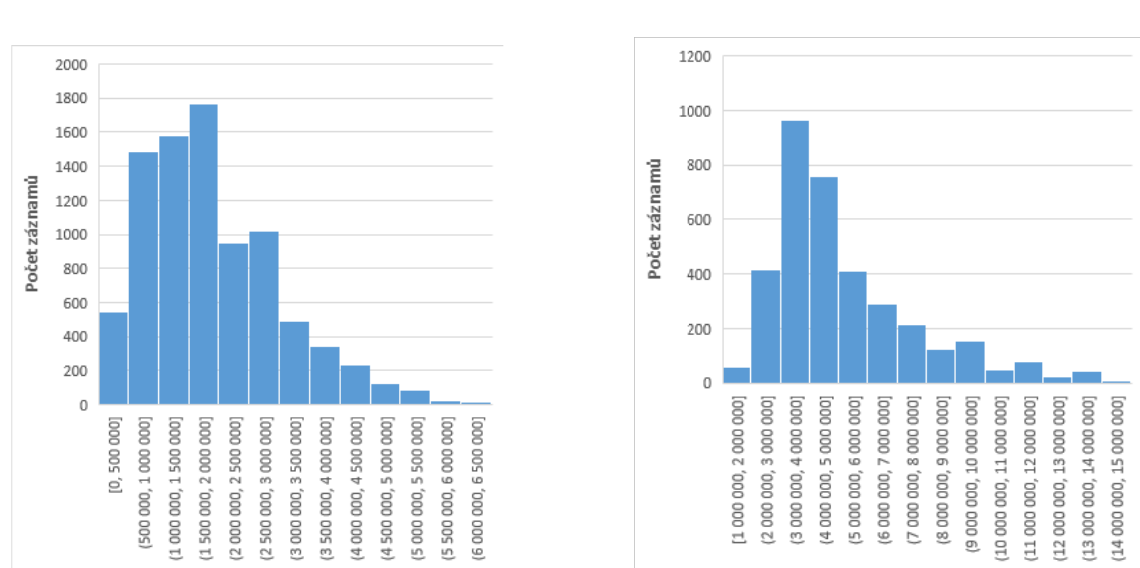
Cenové rozpětí u prodeje bytů Následující dva grafy znázorňují počty inzerátů rozdělených do cenových intervalů, které nabízejí prodej bytu. Pro vyšší vypovídací schopnost byly vytvořeny dva histogramy, zvlášť histogram pro ČR bez regionu Praha a histogram, který obsahuje záznamy pouze z regionu Praha.